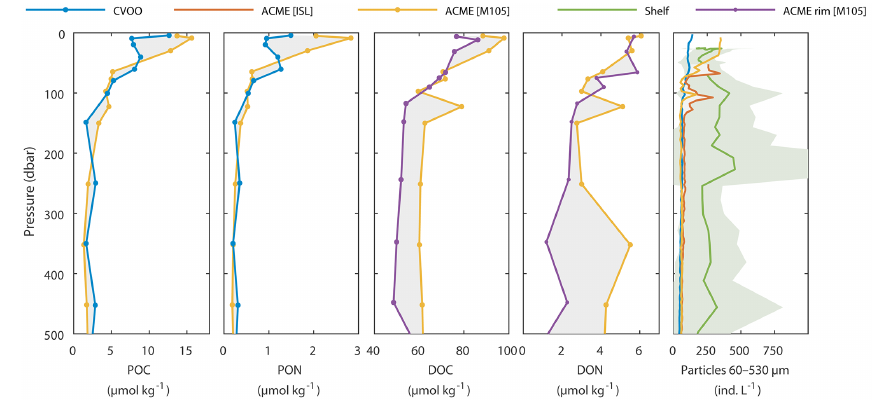
Figure 6. Vertical distribution of particulate and dissolved organic matter (first four panels) based on discrete samples and particle density (60–530µm) derived from high-resolution UVP data (right panel). Note that no data at CVOO exist for DOC and DON; hence data from the eddy rim station is